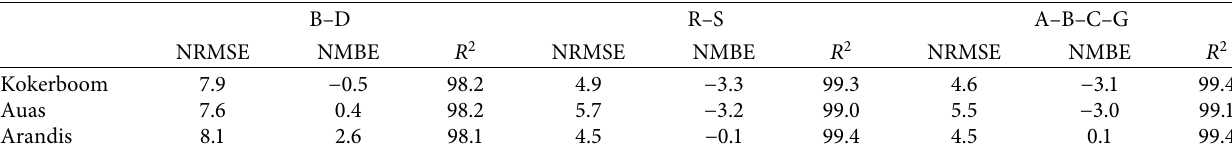
Table 2: Percentage statistical error parameters for the models at different